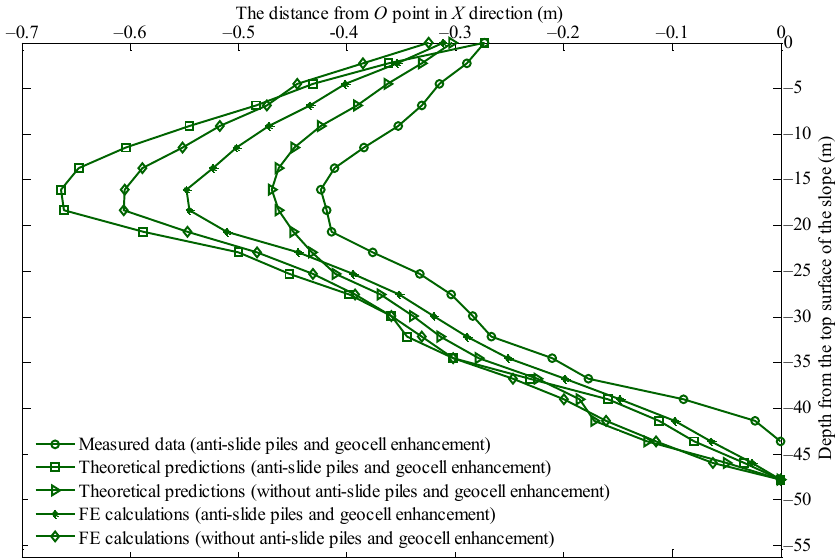
Measured data (anti-slide piles and geocell enhancement) Theoretical predictions (anti-slide piles and geocell enhancement) Theoretical predictions (without anti-slide piles and geocell enhancement) FE calculations (anti-slide piles and geocell enhancement) FE calculations (without anti-slide piles and geocell enhancement) Figure 12. Depth-dependent lateral displacement of the riverbank slope.